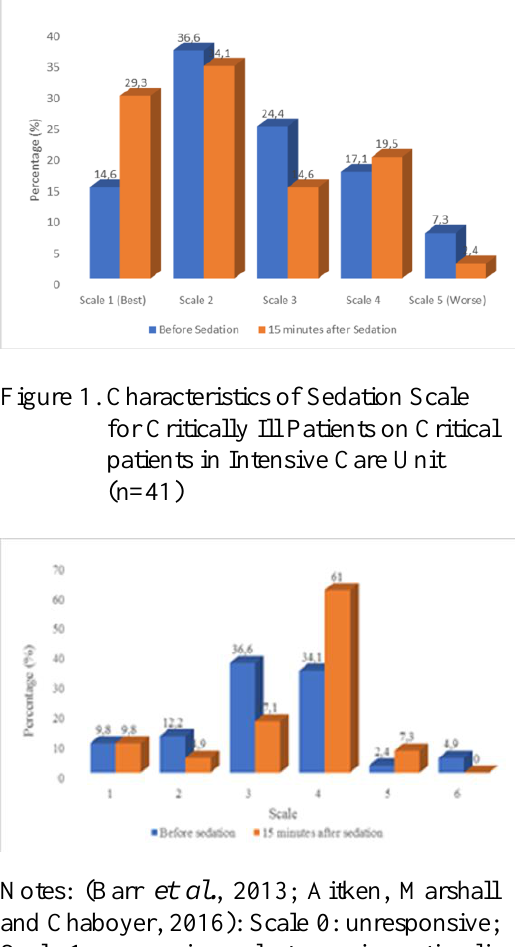
Figure 2. Physical Function on Critical patients in Intensive Care Installation